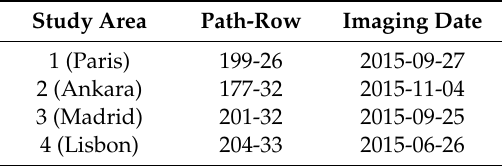
Table 2. Landsat-8 images for the four study